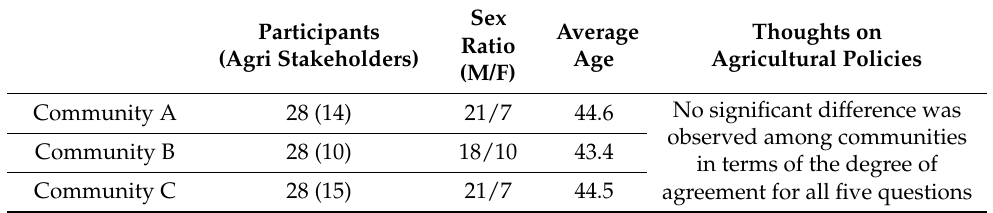
Table 2. Attributes of community participants.